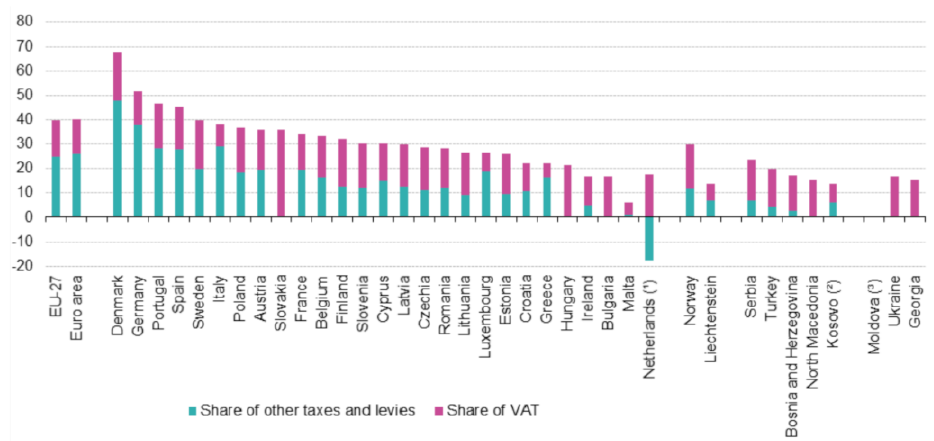
Figure 13. Share of taxes and levies paid by household consumers for electricity, second half 2019